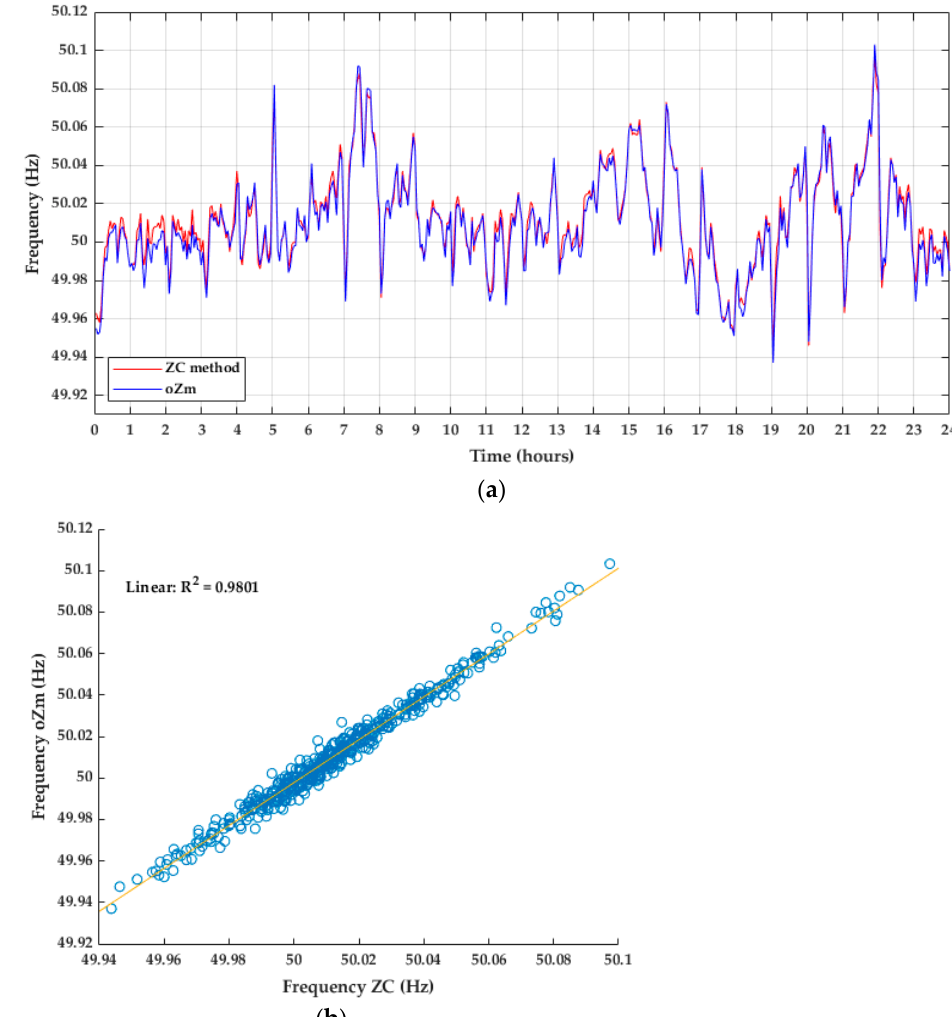
Figure 10. Comparison between the ZC method and the oZm. ( a ) Daily frequency of 3 May 2021; ( b ) Linear regression.